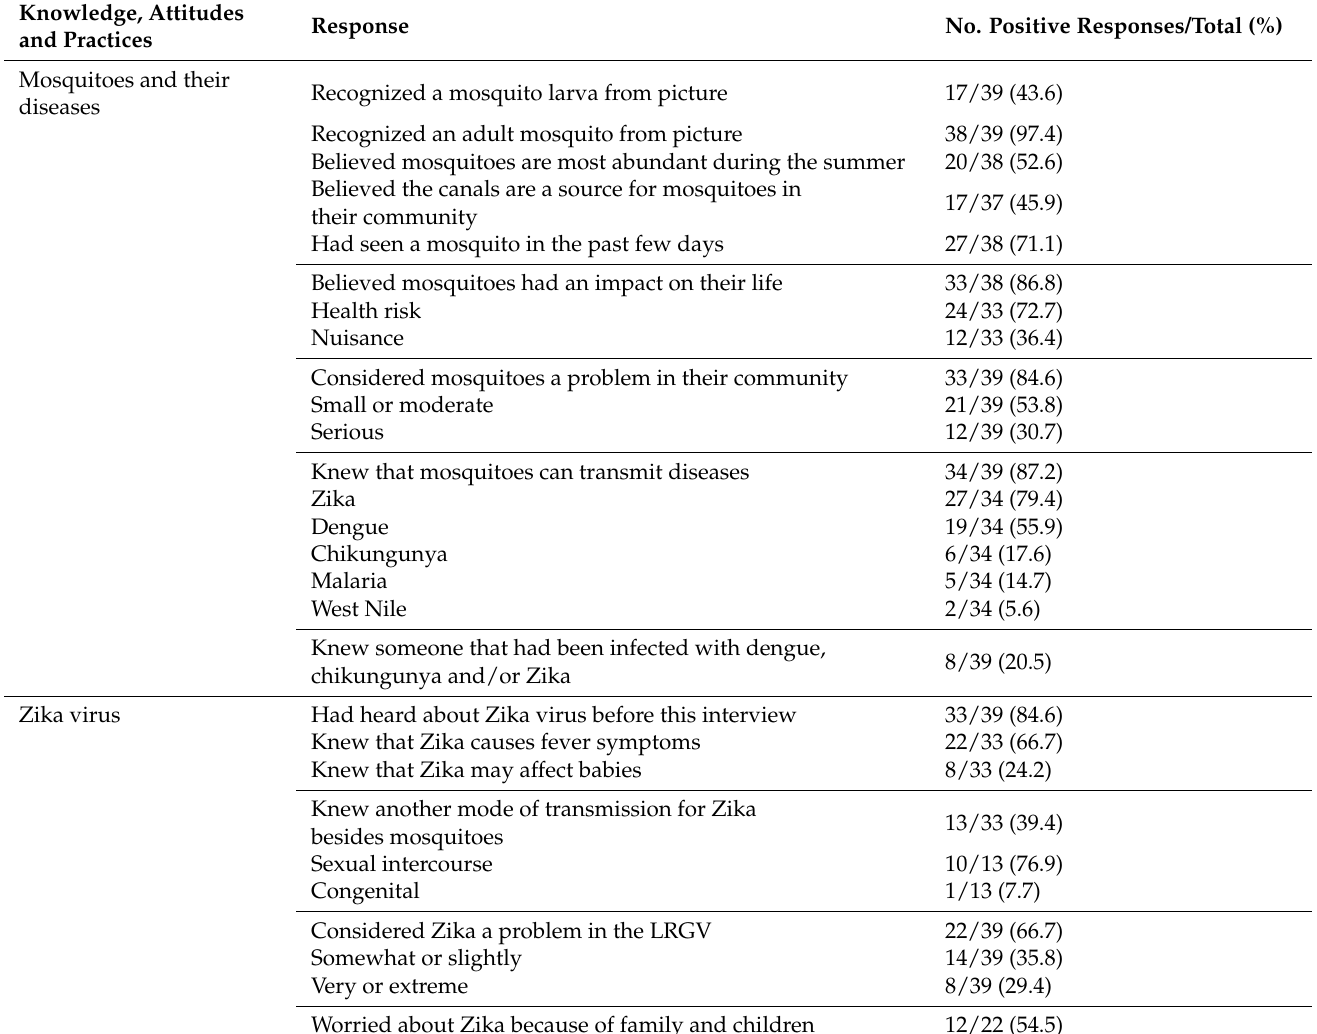
Table 3. Knowledge, attitudes, and practices of household owners in the Lower Rio Grande Valley, related to mosquitoes, their diseases, and